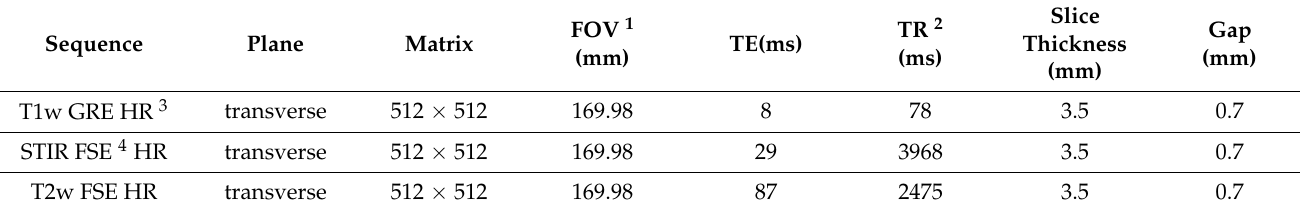
Table 1. MRI sequences used for 0.27 T low-field MRI.